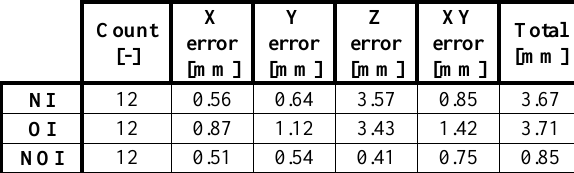
Table 2. Ground control points positioning error computed through Root Mean Square Error